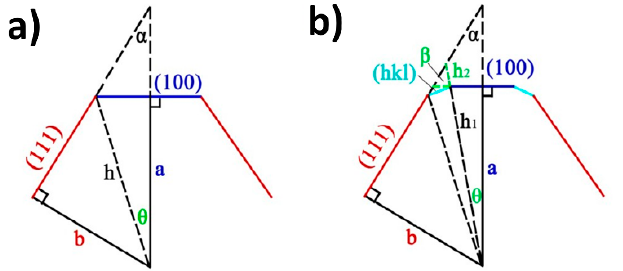
Figure 2. Geometrical construction for prediction of ratio of {111} and {100} index facets. The red and blue lines are assigned to the {111} and {100} facets, respectively, and cyan represents {hkl} plane. ( a ) Only low index facets and ( b ): both low and high indexed facets Reprinted with permission from ref. [154].